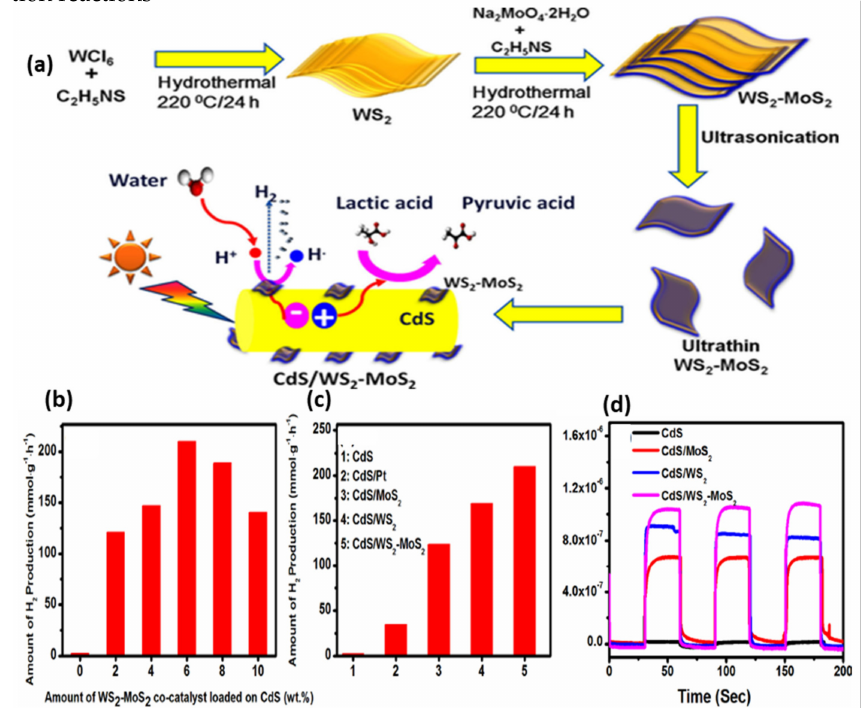
Figure 17. ( a ) Schematic diagram of preparation of a WS 2 –MoS 2 /CdS heterostructure with the proposed mechanism for the photocatalytic water-splitting process. ( b ) Amount of H 2 evolution in aqueous solution with different wt% of WS 2 –MoS 2 . ( c ) Comparison between the hydrogen evolution amount using different photocatalysts. ( d ) Photocurrent responses of the various prepared catalysts. Reproduced with permission [152]. Copyright 2017,